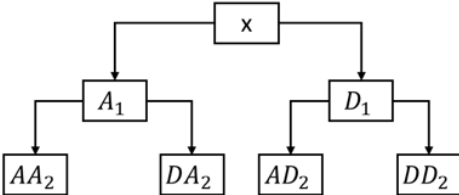
Figure 3. Level 2 decomposition using wavelet packet transform where X is the original signal, A 1 is the approximation component, D 1 is the detail component, AA 2 is the approximation component of A 1 , DA 2 is the detail component of the A 1 , AD 2 is the approximation component of D 1 , DD 2 is the detail component of D 1